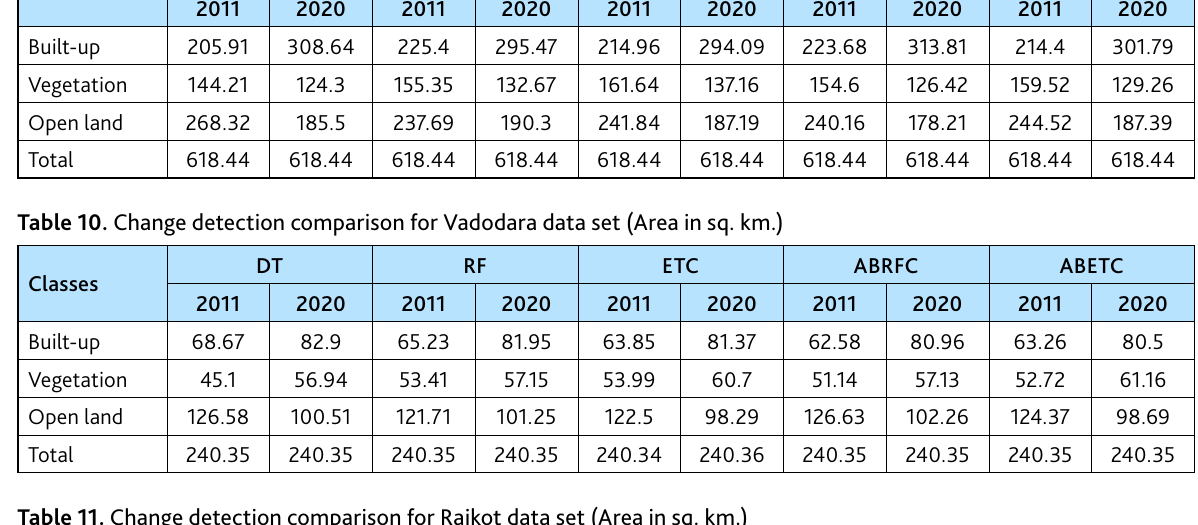
Table 11. Change detection comparison for Rajkot data set (Area in sq. km.) Classes